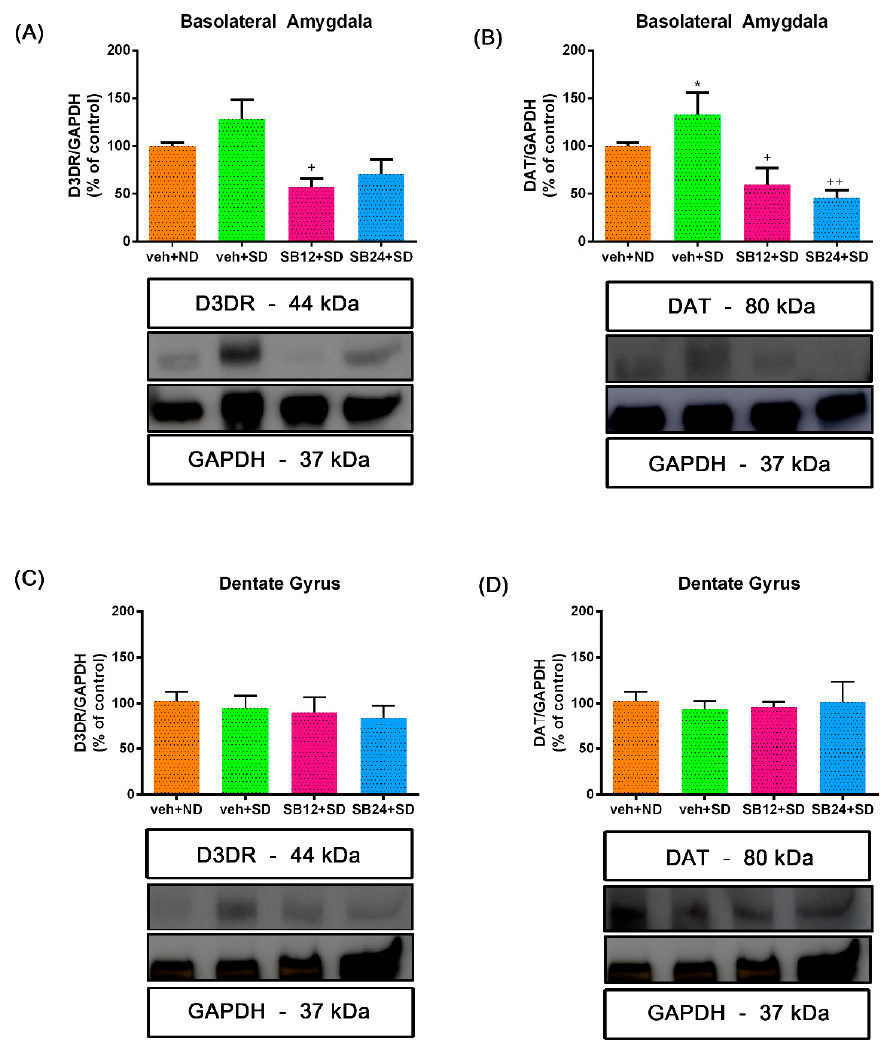
Figure 4. Semiquantitative analysis and representative immunoblot of dopamine receptor (D3DR) and dopamine transporter (DAT) in the basolateral amygdala (( A , B ), respectively) and dentate gyrus (( C , D ), respectively). Mice were conditioned to cocaine and after 60 days of abstinence they were injected with vehicle and exposed to a non-defeated agonistic encounter (veh+ND; controls) or exposed to an agonistic encounter with social defeat (veh+SD). Additionally, a group of animals was injected with the D3DR antagonist SB-277011-A (12 or 24 mg/kg i.p.) prior to the social-defeated agonistic encounter (SB12+SD and SB24+SD, respectively). A preference test was conducted giving the animals free access to both compartments of the CPP apparatus for 15 min. Mice were sacrificed immediately after the reinst test. * p < 0.05 vs. veh+ND; + p < 0.05, ++ p < 0.01 vs. veh+SD. No significant changes in D3DR or DAT levels were found between groups in the dentate gyrus. Each bar corresponds to mean ± standard error of the mean (n = 6–8 per group).